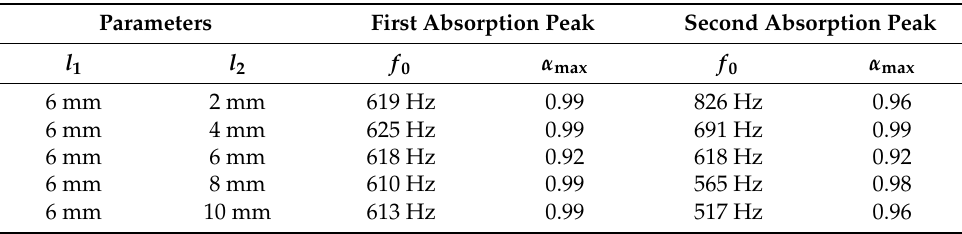
Figure 5. The influence of length of the aperture to sound absorption performance of the double resonators in simulation. Table 2. The summary of the peak sound absorption coefficient α max and resonance frequency f 0 for double resonators with different length of the aperture.